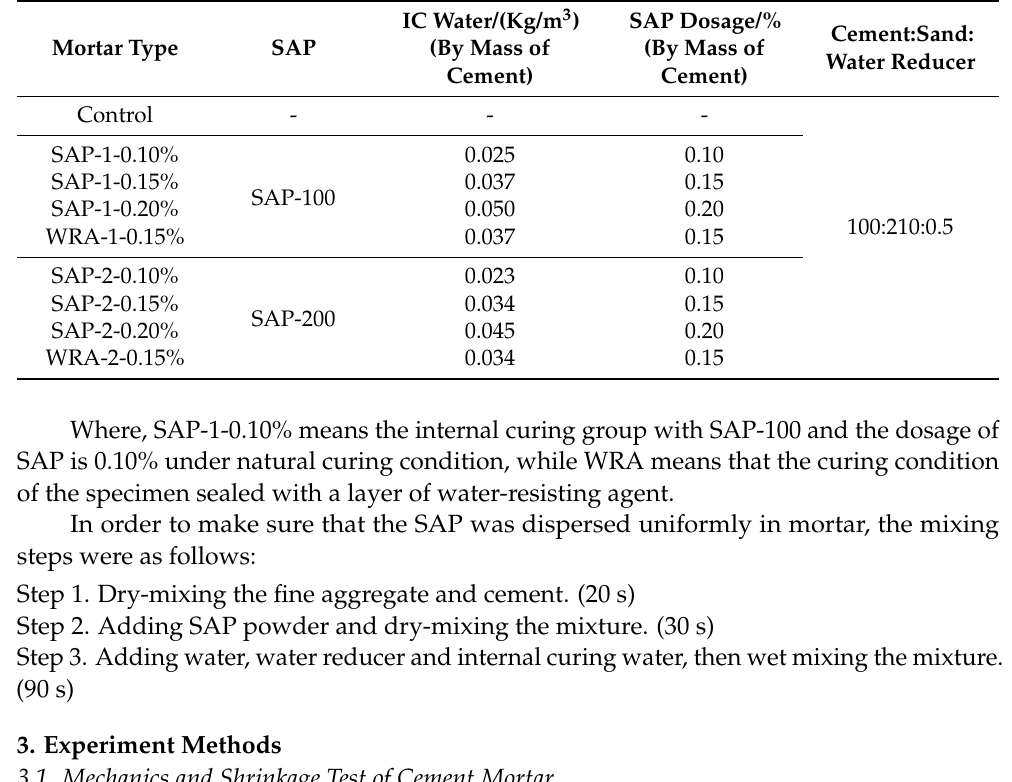
Table 3. Mix proportion of